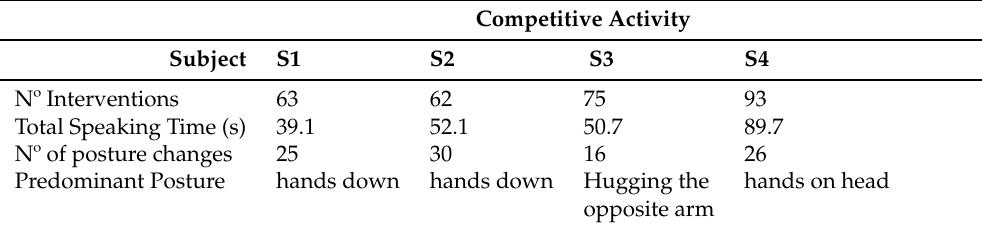
Table 4. Competitive Activity Measurements.